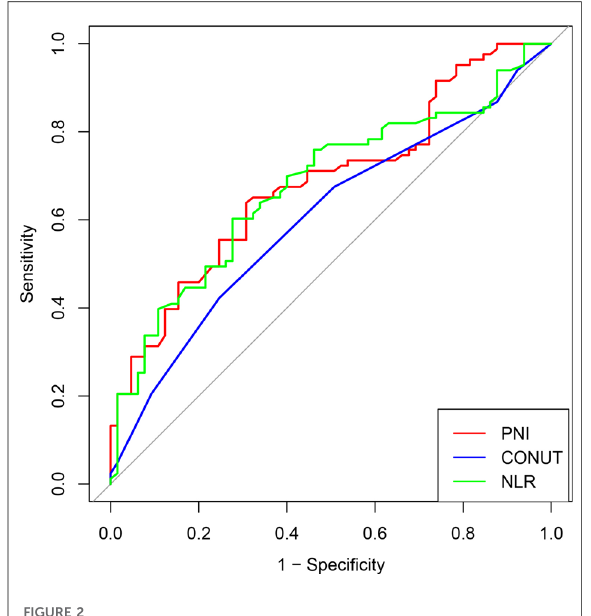
FIGURE 2 ROC curves for INIs related to postoperative